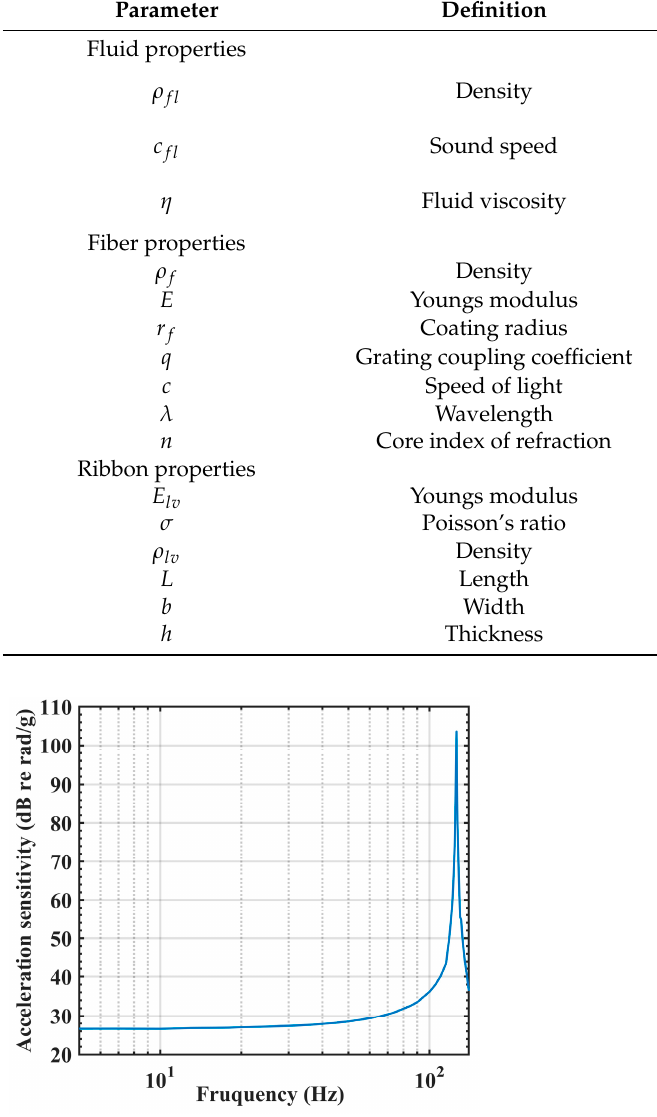
Figure 4. The acceleration sensitivity of the sensor.